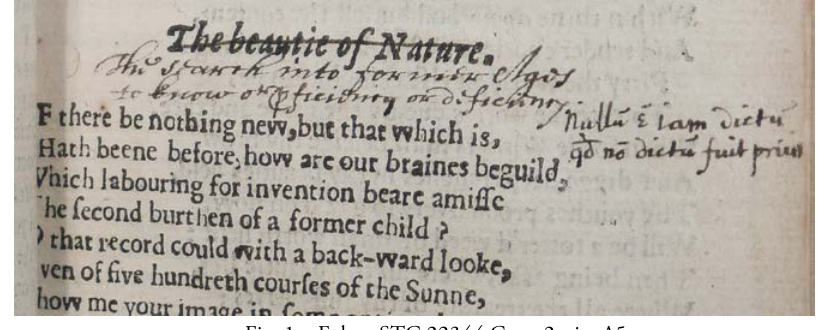
Fig. 1 – Folger STC 22344 Copy 2, sig.